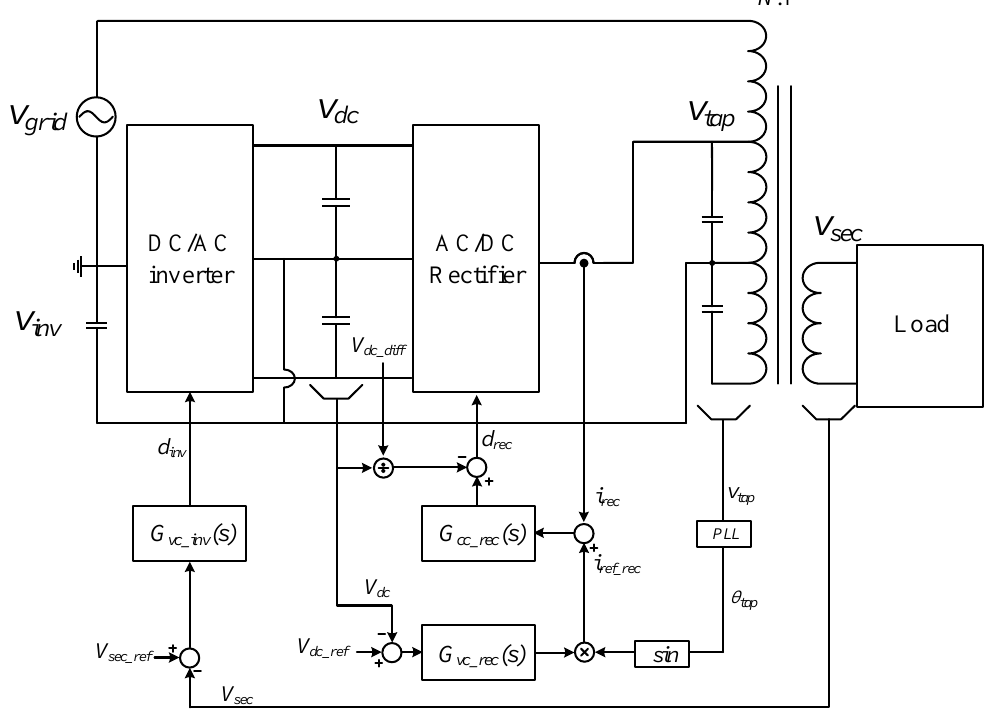
Figure 6. Control structure of proposed two stage active hybrid solid state transformer.